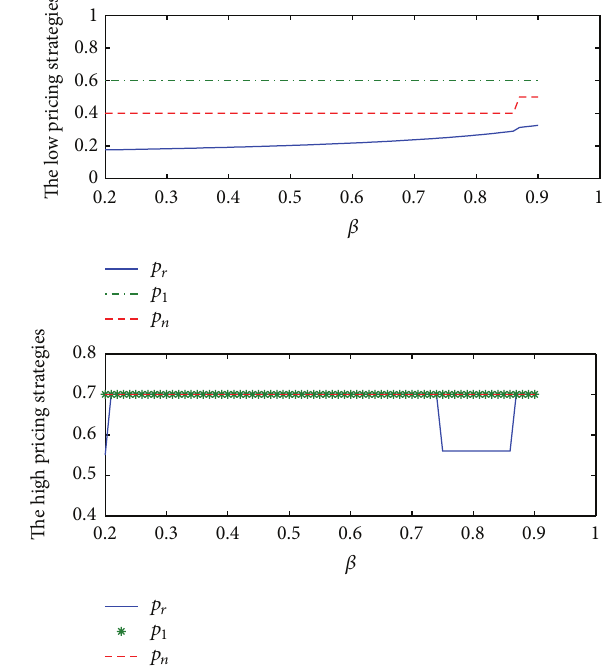
Figure 4: The pricing strategy according to the high disassembla-